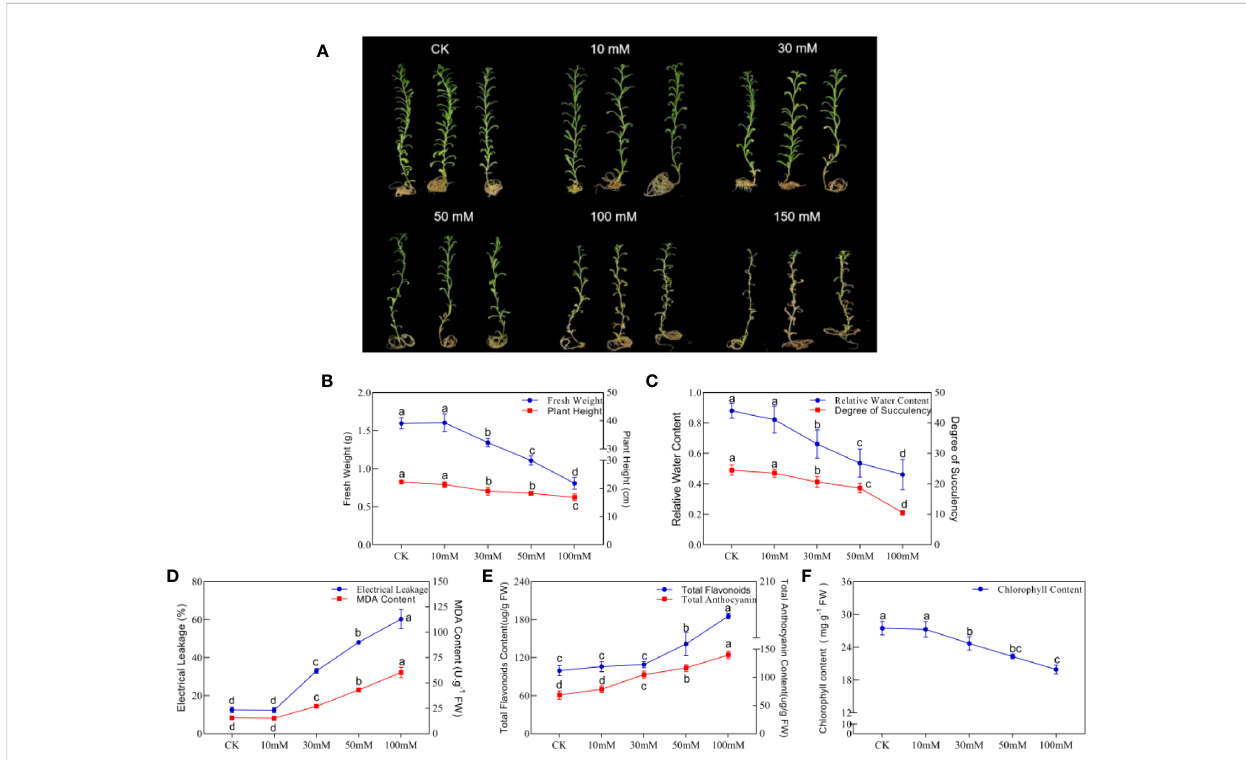
FIGURE 1 Phenotypes and indicators of N. tangutorum treated with different concentrations of alkaline salt(AS). (A) : Phenotype under different alkali treatments (AS: NaHCO 3 : Na 2 CO 3 = 9:1, pH=9.5); (B) : Fresh weight and plant height; (C) : Relative water content and degree of succulent; (D) : Eletrical leakage and MDAcontent; (E) : Total fl avonoids and total anthocyanin content; (F) : Chlorophyll content. Selected 40-day-old plants were treated with different concentrations of alkaline salt(AS)(10/30/50/100/150 mM). Plants grew in Hoagland solution served as controls(CK). Each group was treated with 25 plants and repeated 3 times. Data presented are the mean ± SDs (n=3). Different letters next to the number indicate signi fi cant difference (Duncan multiple range test; P